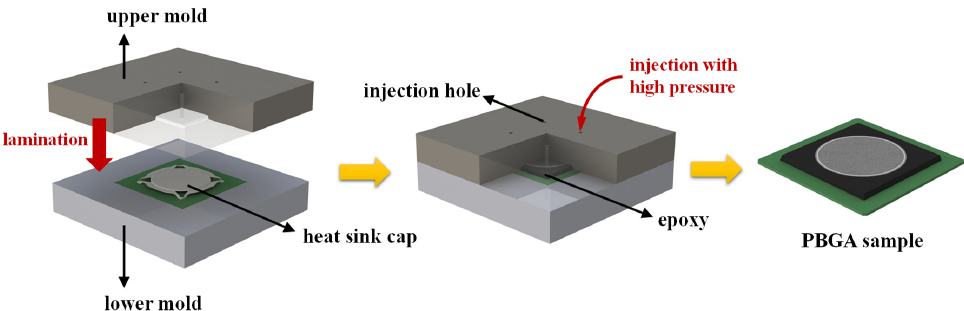
Figure 6. Injection molding illustration of the PBGA packaging process.